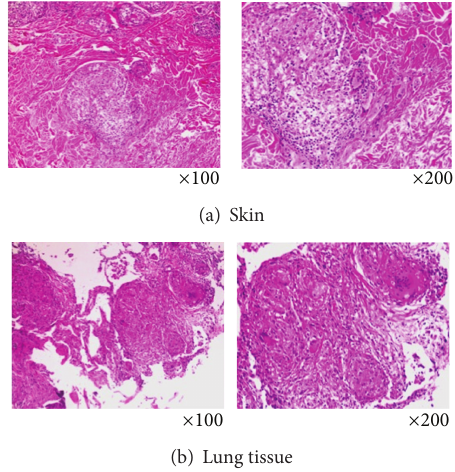
Figure 3: Pathological findings of the skin biopsy specimen from erythematous lesion of anterior chest (a) and TBLB specimen from lung (b) (hematoxylin-eosin staining, left: × 100, right: × 200). Infiltration of lymphocytes and epithelioid cells and noncaseating granuloma with Langhans giant cells were seen in both